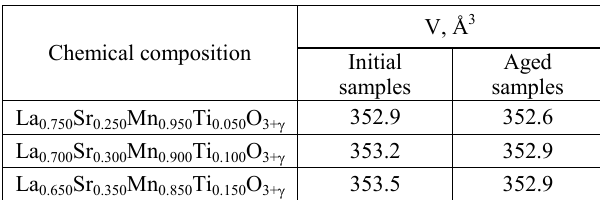
Table 1 . Unit cell volume of manganites in initial state and after 33 months.